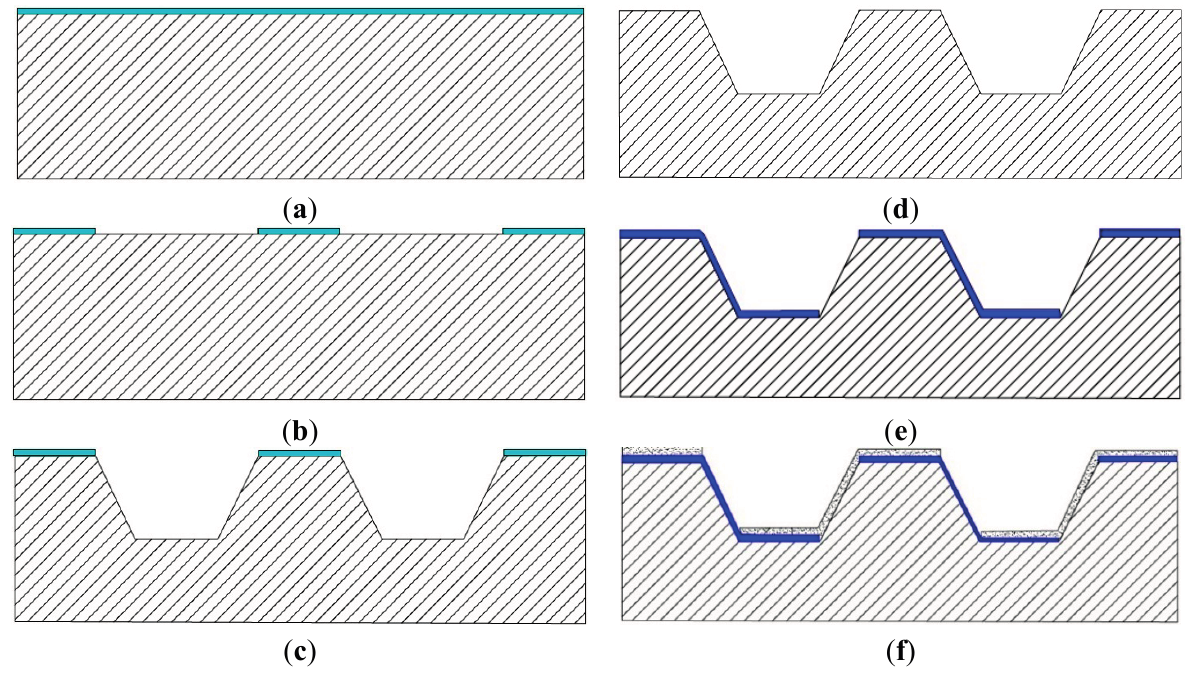
Figure 1. Fabrication process of the thermocouple array. ( a ) Oxidized Silicon wafer;